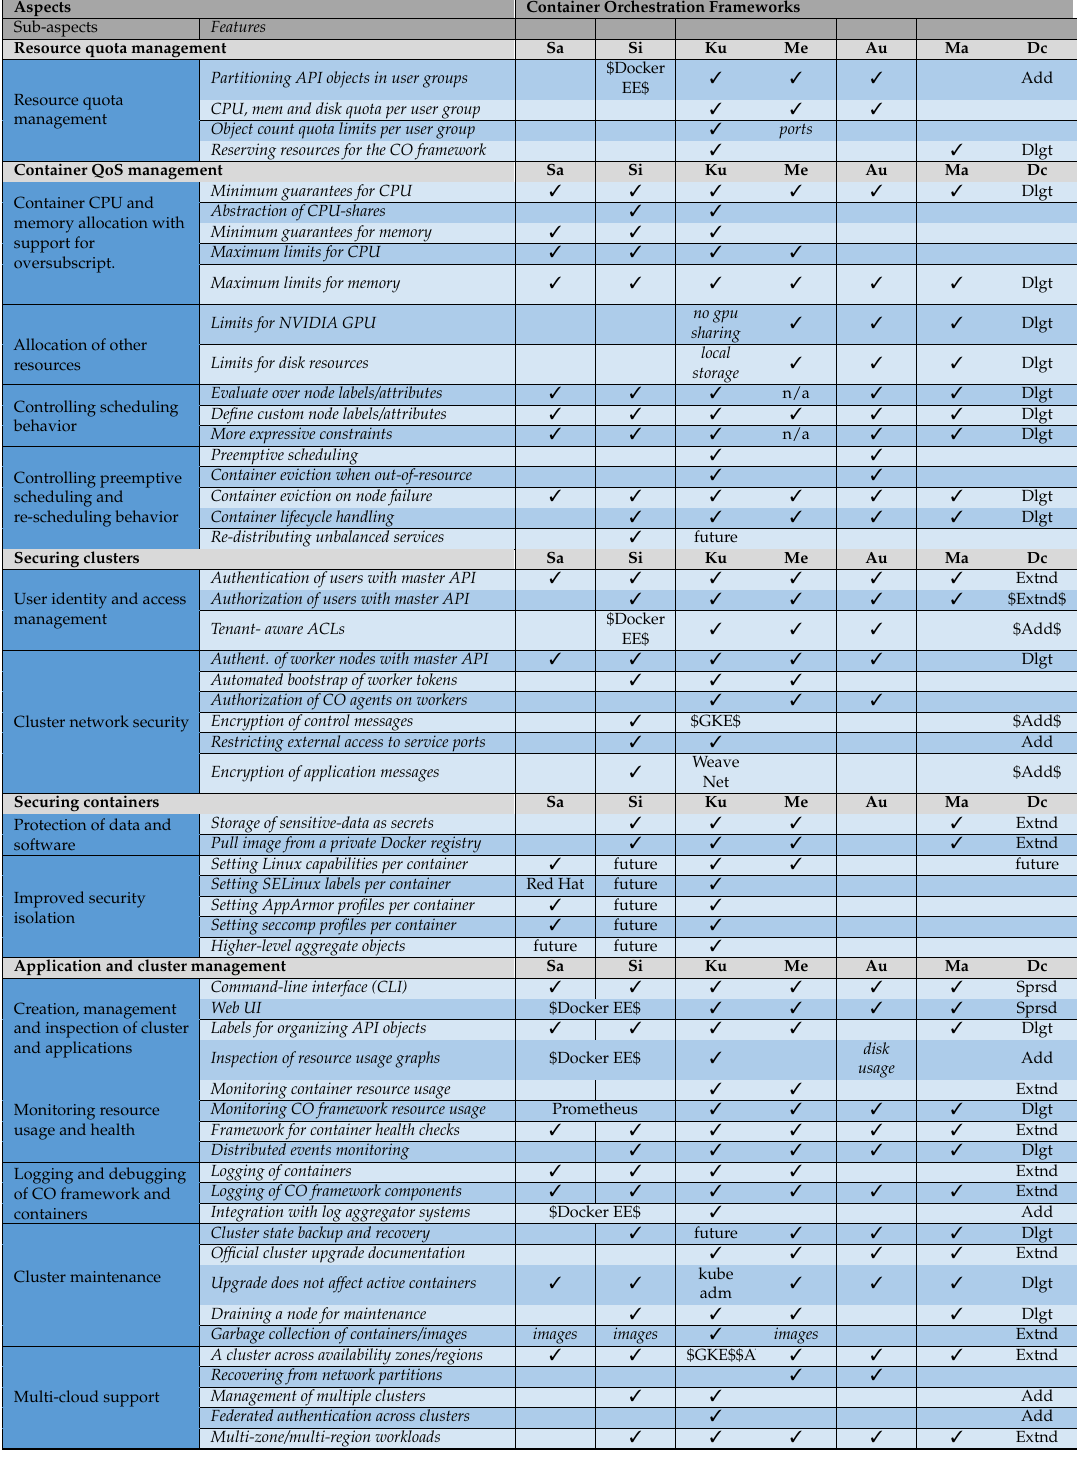
Dlgt Dlgt Dlgt Dlgt Dlgt